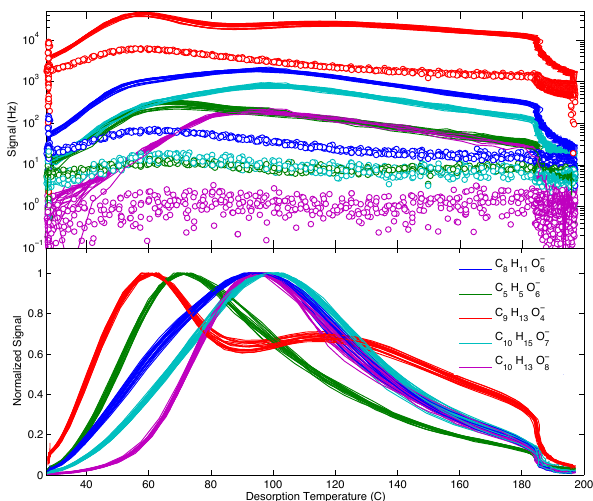
Fig. 5. Top: selected ion signals (counts per second) are plotted on a log-scale versus N 2 carrier gas temperature during thermal desorp- tions of α -pinene ozonolysis derived organic aerosol particles (solid lines) and of corresponding filter blanks (open circles). Repeated equal duration particle collection and desorptions are shown from a 2-day period sampling from constant chamber conditions. The filter blank is factors of 10 to 100 lower than the particle-laden chamber sample depending on the specific composition of the compound. Bottom: the same particle desorption signals are shown normalized to the maximum signal on a linear scale for clarity. As tempera- tures near 200 ◦ C signals drop smoothly towards background levels during the soak period of the heating cycle. The structure of the des- orptions is highly reproducible both in amplitude and temperature space. The details of the bimodal features are discussed further in the